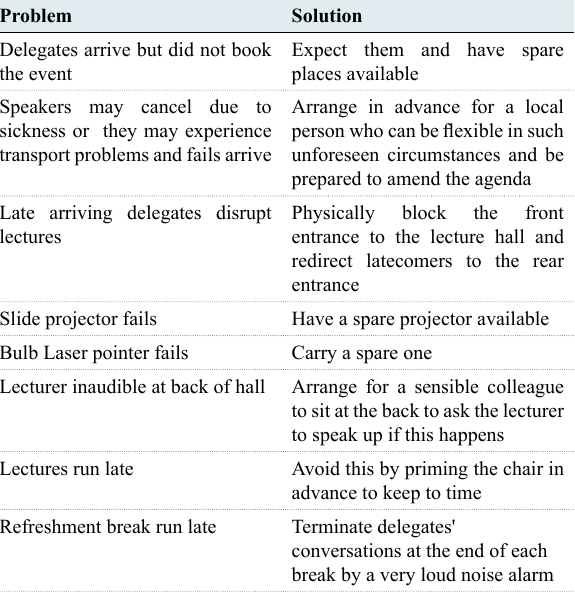
Table 1: Anticipated Problems on the conference